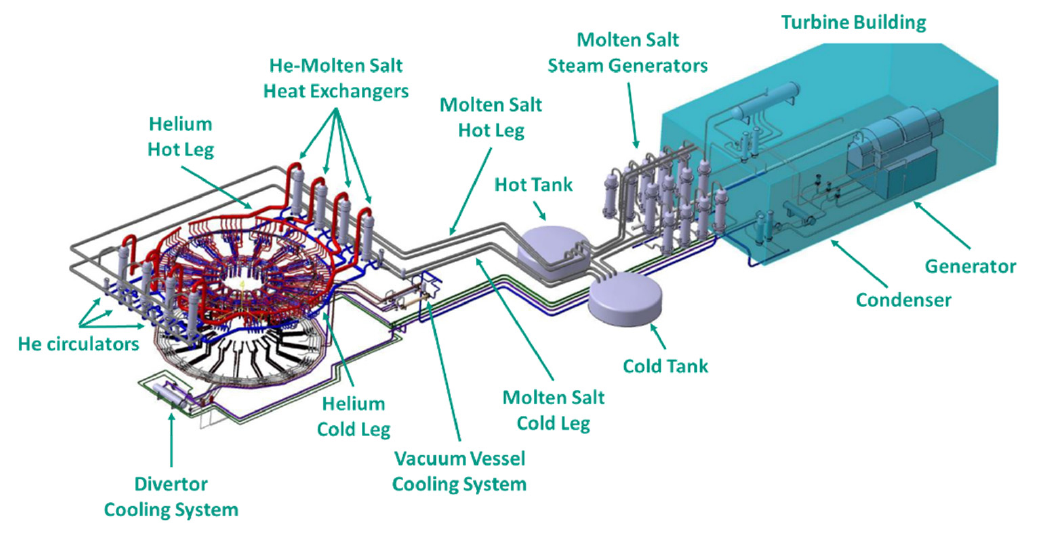
Figure 1. Layout of the HCPB ICD BOP configuration.